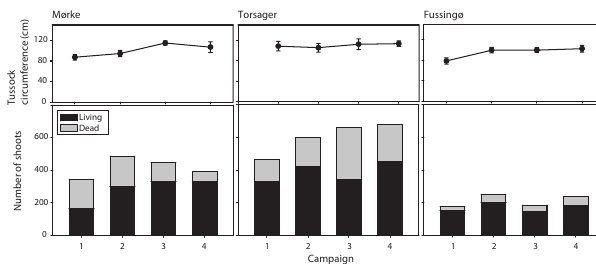
Figure 2. Mean circumference ( ± standard error, n = 4) and num- ber of living and dead shoots ( n = 4) of the tussocks in Juncus ef- fusus sampling quadrats at the three sites, during the four sampling